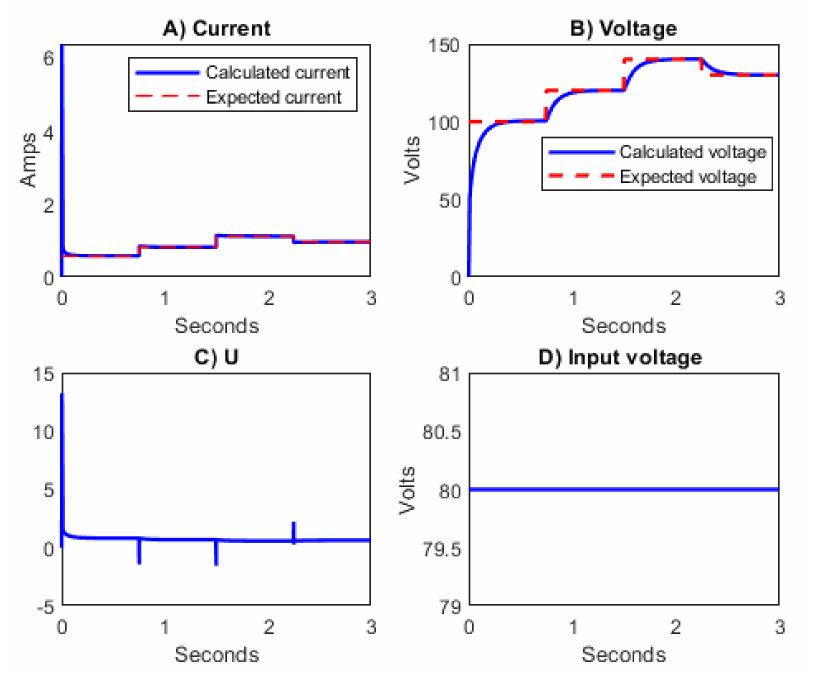
Figure 5. ( A ) Shows current behavior, ( B ) boost converter output voltage under changes in reference voltage, ( C ) duty cycle, and ( D ) input voltage.